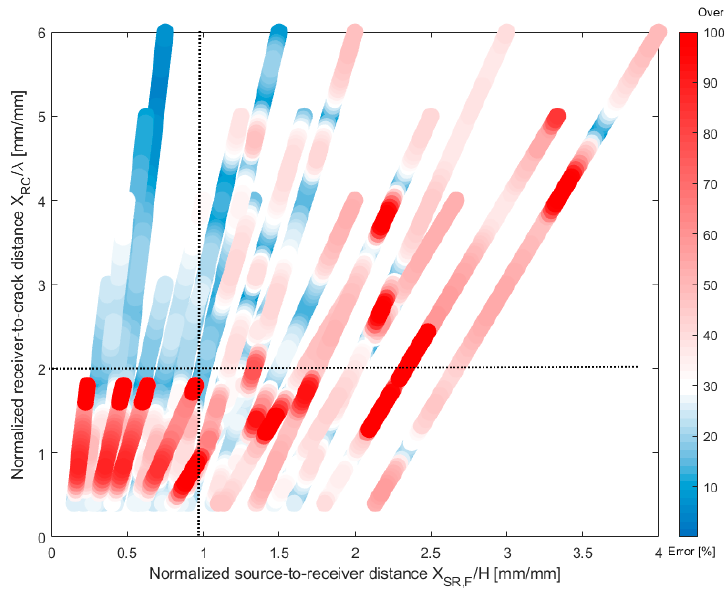
Figure 12. 2D scattering plot representing the error in predicted crack depth, Error depth , using SWT measurements across a surface-breaking cracks ( h = 0, 10, 20, 30, 40, and 50 mm) in a plate with various thicknesses (100, 150, 200, 300, 400, and 800 mm) with the two normalized receiver locations, x SR,F / H , and x RC / λ R .